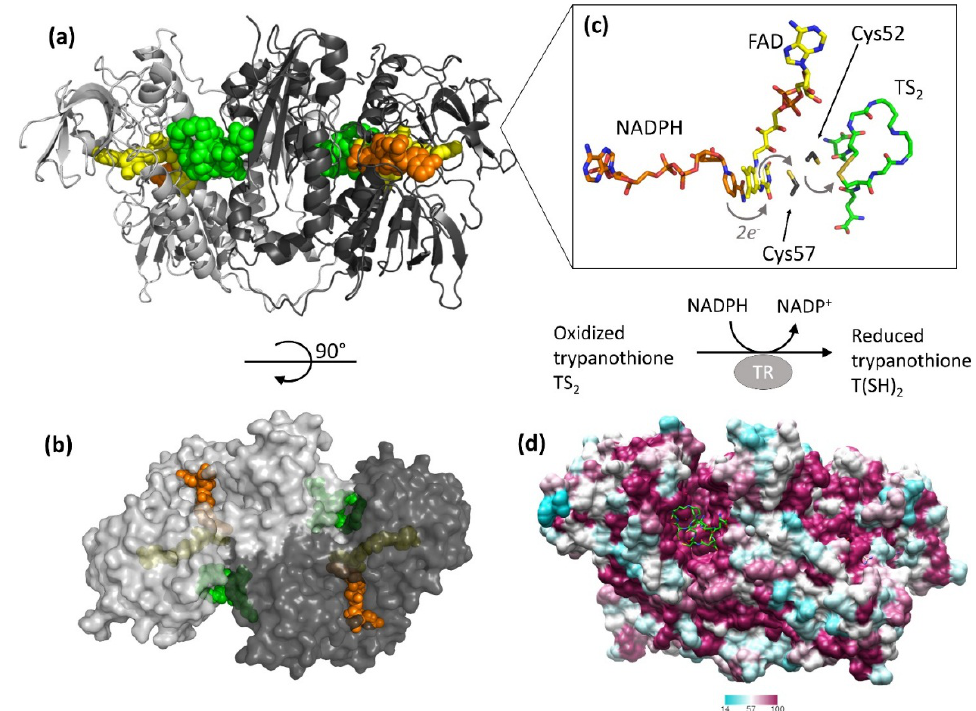
Figure 1. Structure and activity of trypanothione reductase (TR). ( a,b ) Two views of TR dimer from T. brucei (PDB: 2wow) are shown. NADPH (orange), FAD (yellow), and trypanothione (green) are represented as spheres to highlight the binding sites. ( c ) The detail shows all entities involved in the electron transfer from NADPH to trypanothione. For clarity, trypanothione is depicted as modeled in TR from T. cruzi (PDB: 1bzl), where a single oxidized conformation is observed in the absence of NADPH. ( d ) Sequence conservation of TR. The dimer of TR from T. brucei (PDB: 2wow) is colored according to the percentage of amino acid identity with respect to other representative TR sequences ( C. fasciculata , T. cruzi , T. congolense , T. brucei , L. braziliensis , L. infantum , L. major ). Trypanothione, represented as green sticks, assumes multiple conformations in the wide and highly conserved binding cavity.